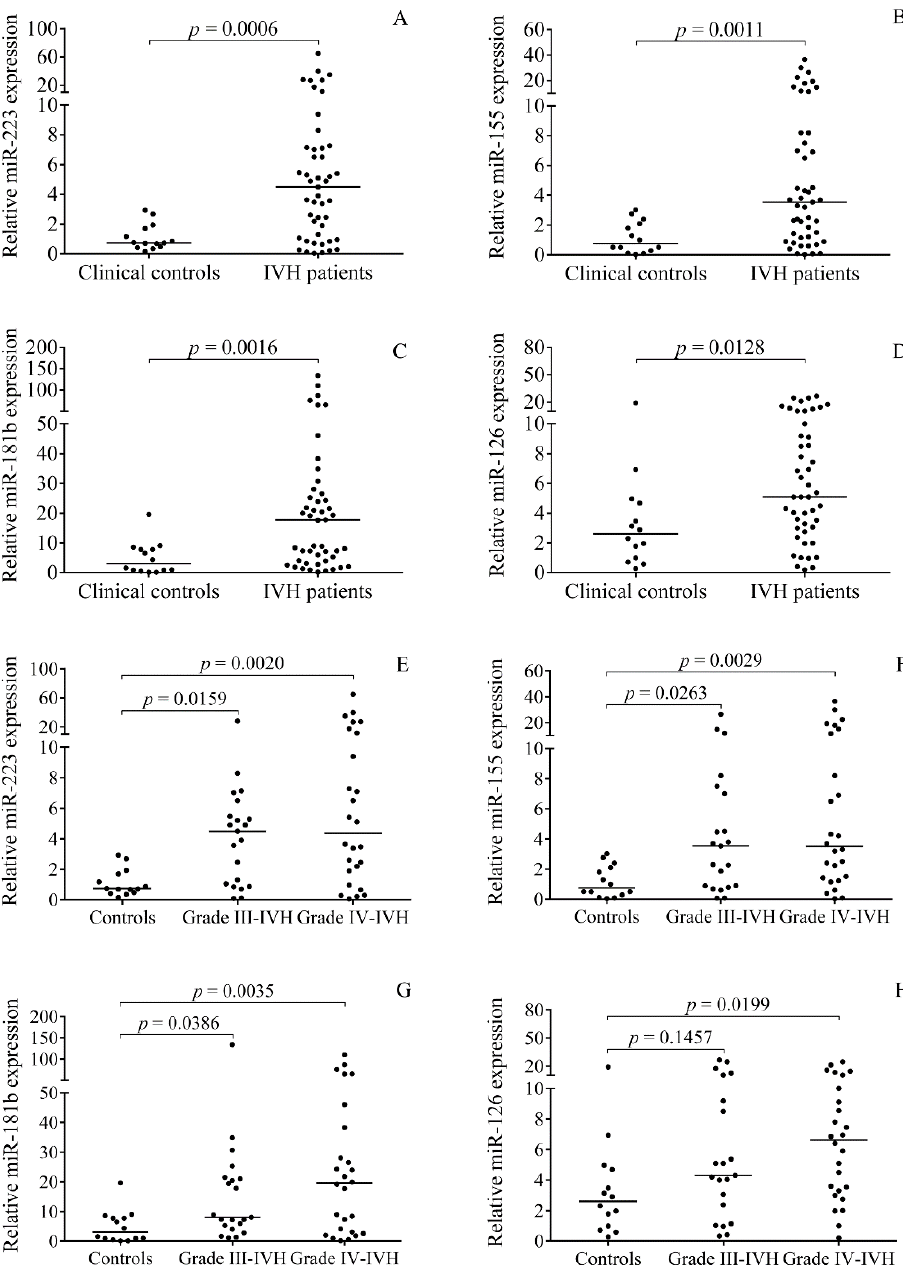
Figure 1. Analysis of CSF miRNA levels after the onset of IVH. Relative expressions of miR-223 ( A ), miR-155 ( B ), miR-181b ( C ), and miR-126 ( D ) were significantly higher in the entire IVH group ( n = 47) versus controls ( n = 14). However, no differences in miRNAs were seen between grades III ( n = 21) and grade IV ( n = 26) IVH ( E – H ). Dots represent single expression values. Median values are depicted. To compare the data of the two groups, Mann–Whitney U test was applied ( A – D ). Kruskal–Wallis test with Dunn’s multiple comparisons test was performed for the comparison of three groups ( E – H ). CSF: Cerebrospinal fluid, IVH: Intraventricular hemorrhage, miRNA: MicroRNA.